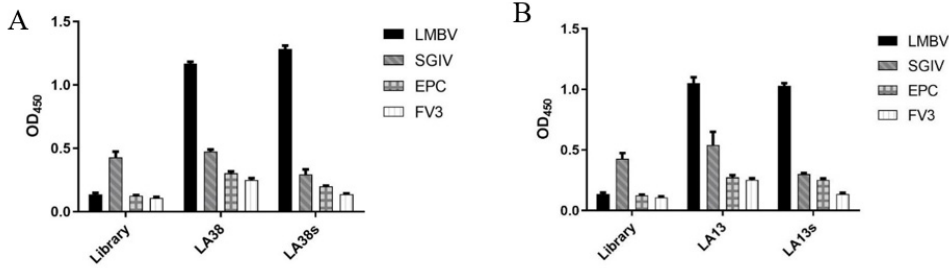
Figure 1. Specificity of truncated aptamers: ( A ) The specificity of the truncated aptamers LA38s and original LA38 against LMBV. ( B ) The specificity of the truncated aptamers LA13s and original LA13 against LMBV. The initial ssDNA Library, SGIV, EPC cells and FV3 served as controls.